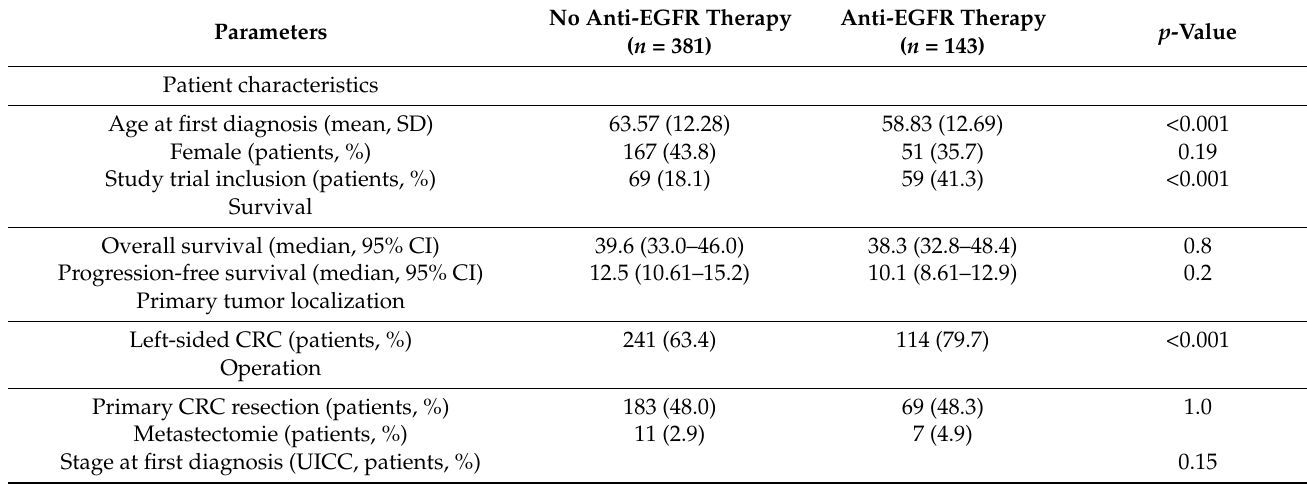
Table 1. General patient characteristics in the overall mCRC